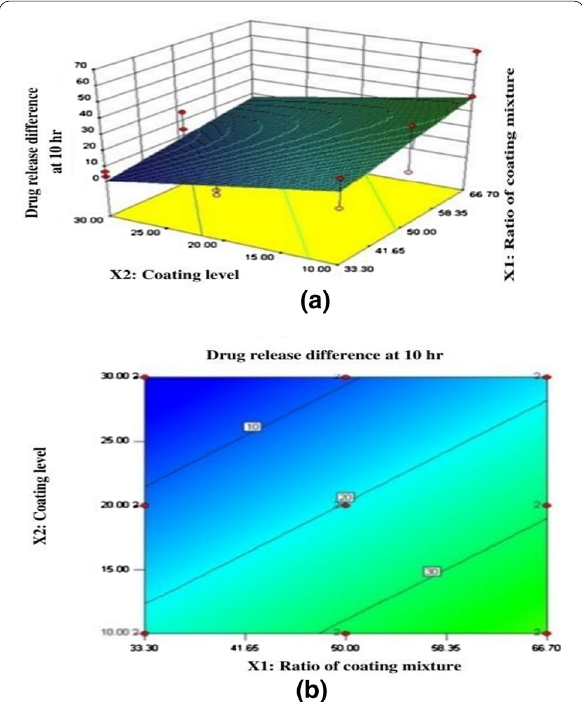
Fig. 6 Response surface method analysis for (Table 2) Y 3 [ a response surface plot & b response contour plot]